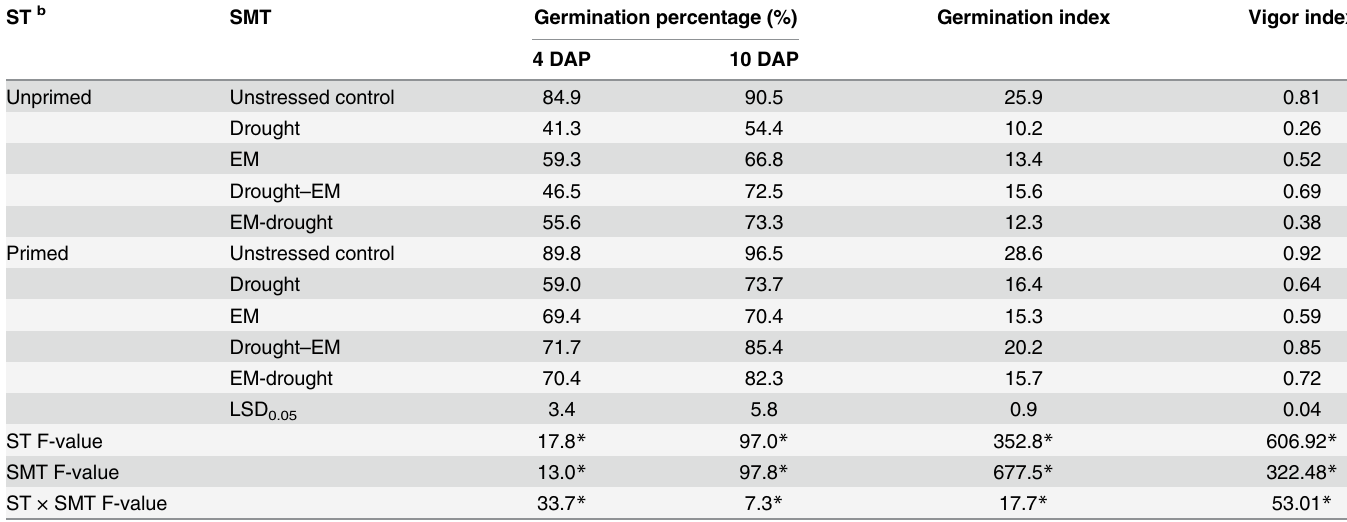
Table 1. Effect of seed priming with PEG and soil moisture stress on sorghum